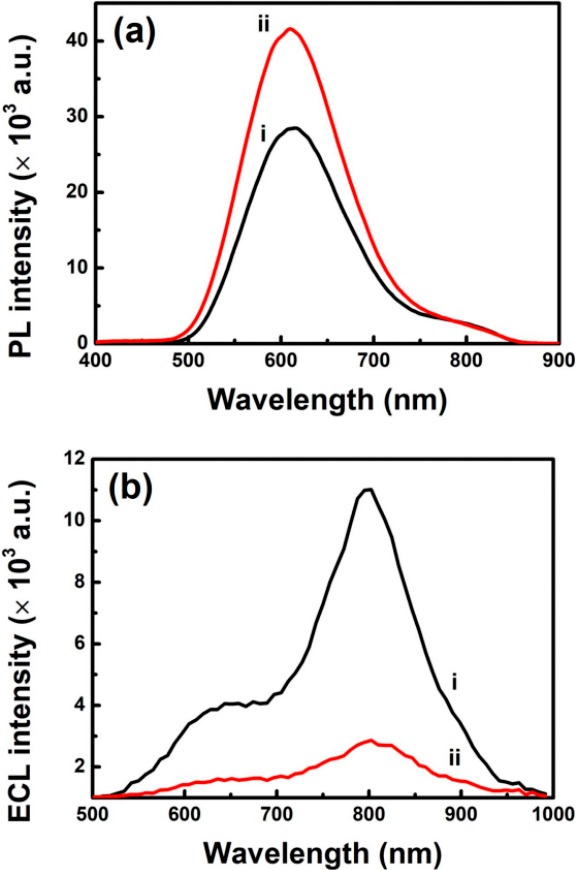
Figure 5. ( a ) PL emission spectra of (i) as-synthesized Au NCs and (ii) dopamine-conjugated Au NCs. λ ex = 365 nm. Concentration of Au NCs: 1.5 mg/mL. ( b ) ECL spectra of (i) as-synthesized Au NCs and (ii) dopamine-conjugated Au NCs in the presence of 0.5 M TEA as a co-reactant. Electrolyte: 0.1 M KNO 3 . Applied potential: 1.3 V. Concentration of Au NCs: 0.75 mg/mL.